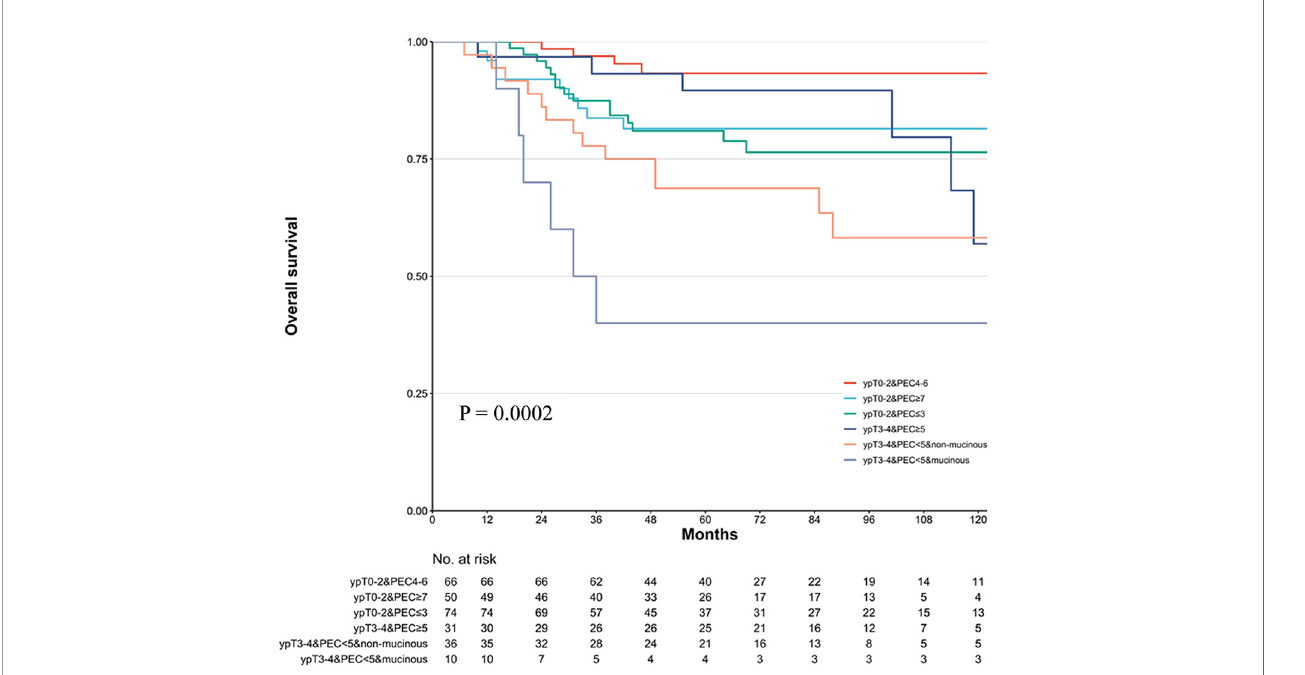
FIGURE 7 | Kaplan – Meier survival plot of the overall survival (OS) in six risk levels classi fi ed by decision tree model. p-value stands for log-rank test. The trending log-rank p trend < 0.001.